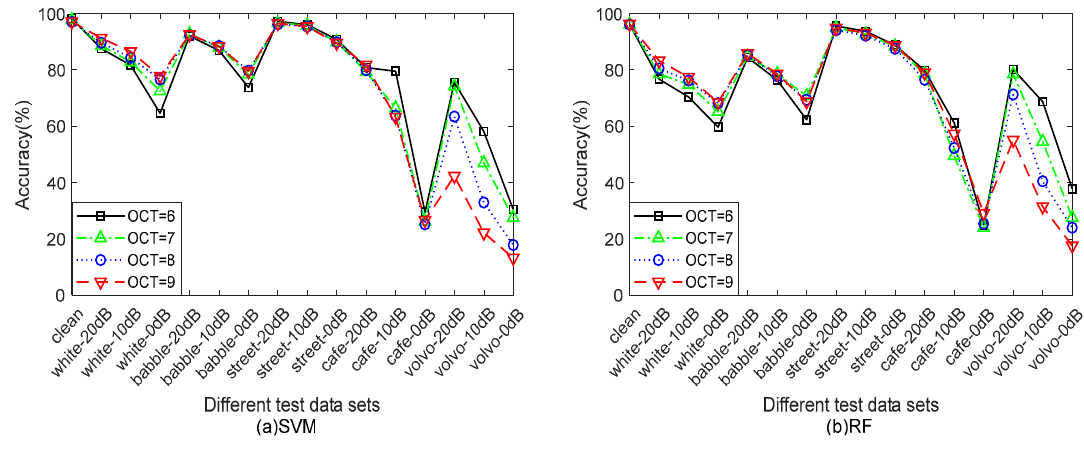
Figure 6. Comparison of different OCT values.